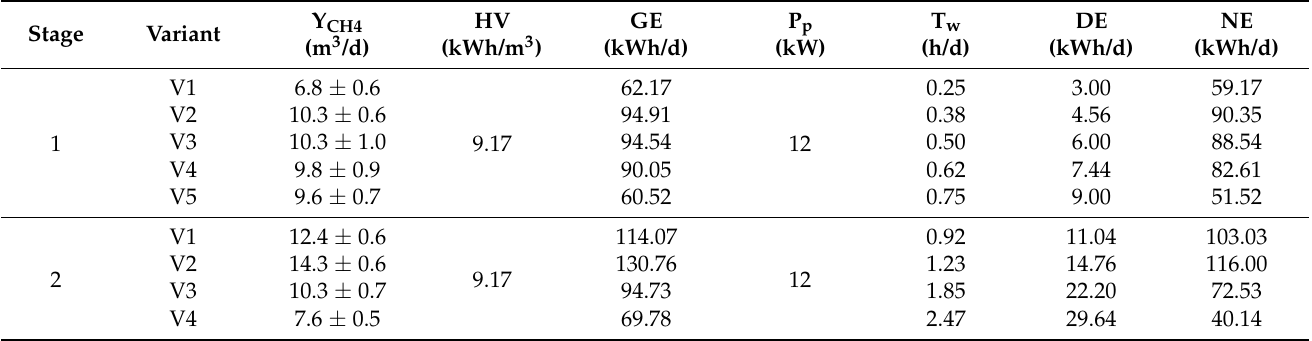
Table 6. Energy balance of the anaerobic digester depending on the stage and variant of the experi- ment (Y CH4 —methane yield, HV—the heating value of methane, P p —power of pumping system, T w —pump operating time, GE—the gross energy, DE—energy demand for pumping and recircula- tion, NE—net energy